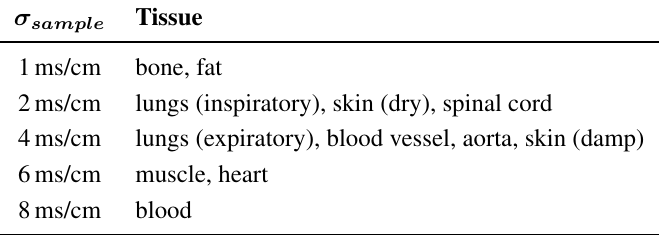
Table 2. Sample conductivity, σ for 10 MHz